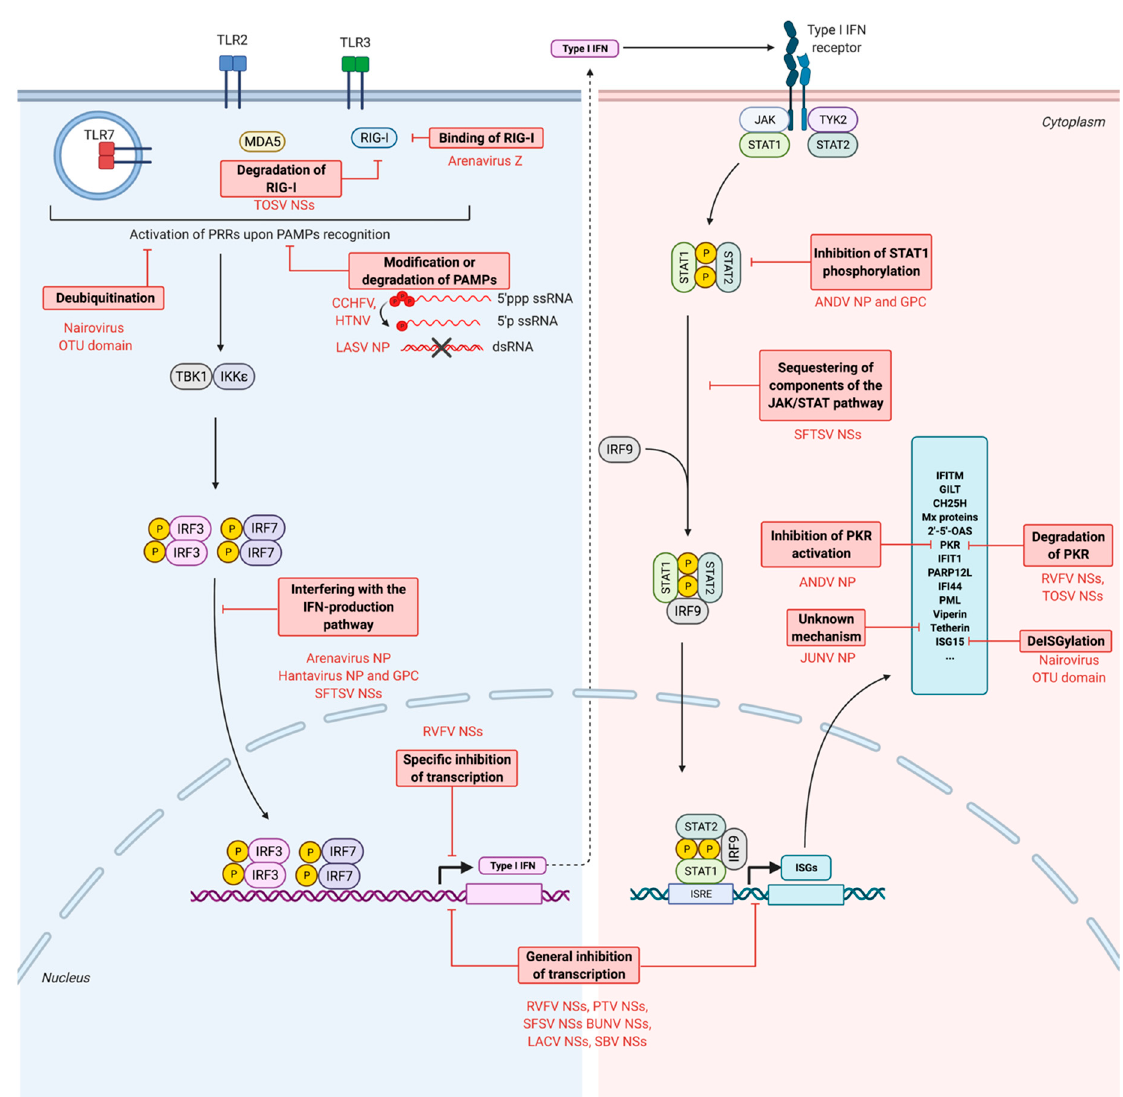
Figure 3. Viral strategies counteracting the host intrinsic and innate immunity system. Upon detection of pathogen-associated molecular patterns (PAMPs) by pattern recognition receptors (PRRs), pathways are activated leading to the production of type I interferon (IFN). One of them involves the phosphorylation, dimerization and nuclear translocation of IFN regulatory factors 3 and 7 (IRF3 and IRF7). Type I IFN are secreted and act in an autocrine and paracrine manner. Upon recognition by the type I IFN receptor, the signal transducer and activator of transcription proteins 1 and 2 (STAT1 and STAT2) are phosphorylated and associate as a heterodimer, as well as with the IFN regulatory factor 9 (IRF9). This complex translocates to the nucleus to activate the transcription of IFN-stimulated genes (ISGs). Viral countermeasures developed by viruses to inhibit these pathways at different steps are written in red boxes. GPC: glycoproteins precursor; NP: nucleoprotein; OTU domain: ovarian tumor domain. IKK ε : I κ B kinase- ε ; IRF: IFN regulatory factor; ISG: IFN-stimulated gene; ISRE: IFN-stimulated response element; JAK: janus kinase; MDA5: melanoma differentiation-associated protein;